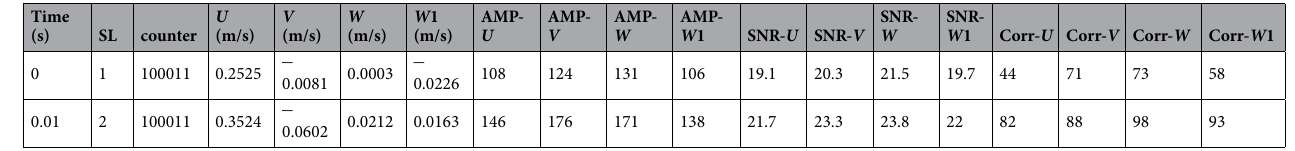
Table 4. An instance of the .dat file obtained from Vectrino